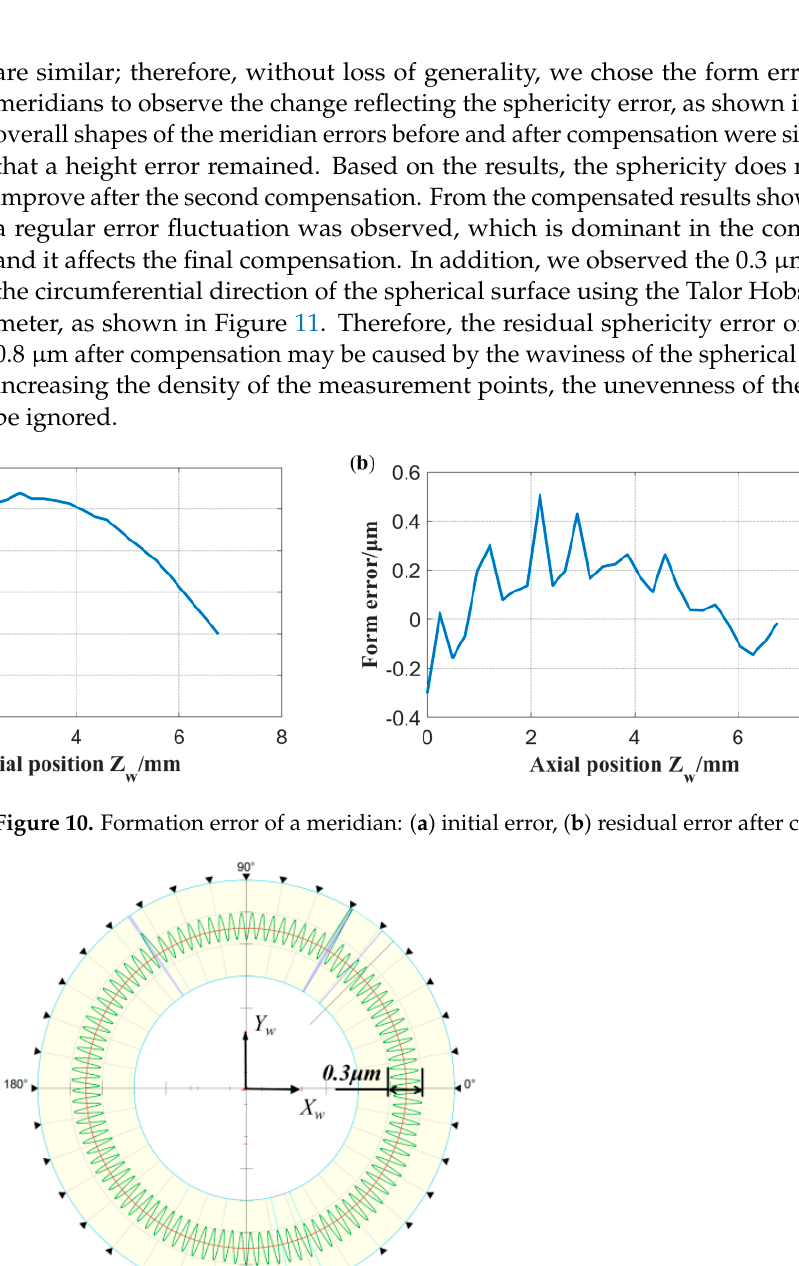
Table 1. Results before and after compensation of height error.